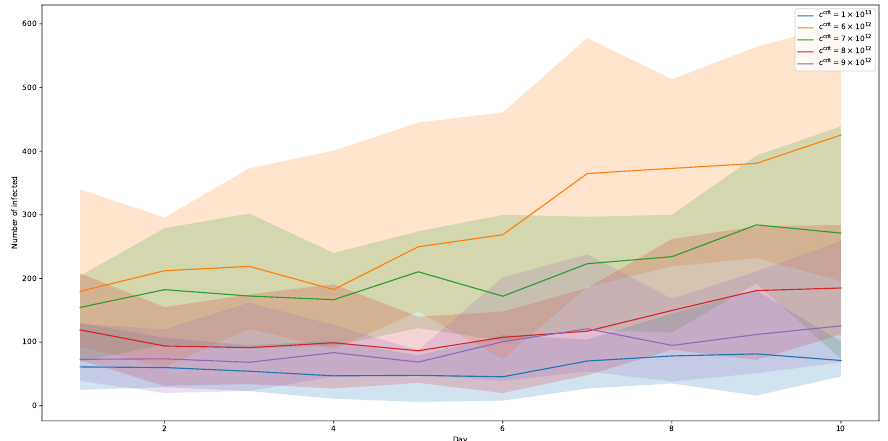
Figure 8. Simulations with one virus-variant of varying contagiousness: Number of infected agents over a simulated period of ten days. Shaded areas show respective minima and